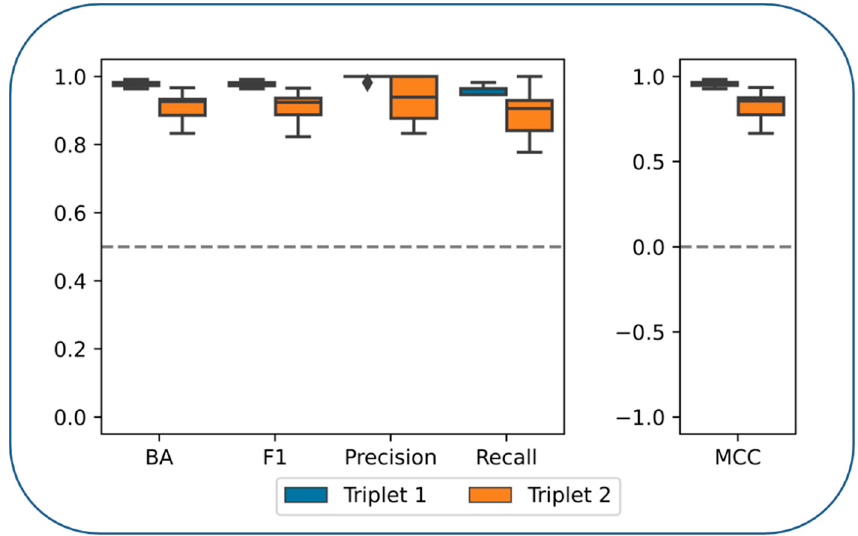
Figure 2. Performances of the balanced random forest classifier. Boxplots represent distributions of balanced accuracy, F1 score, precision, recall and MCC over 10 individual trials for triplet 1 (blue) and triplet 2 (orange). In a boxplot, the horizontal line indicates the median value of the distribution and the upper and lower boundaries of the box indicate the upper and lower quartile, respectively. In addition, whiskers represent the maximum and minimum values of the distribution, and statistical outliers are depicted as diamonds.